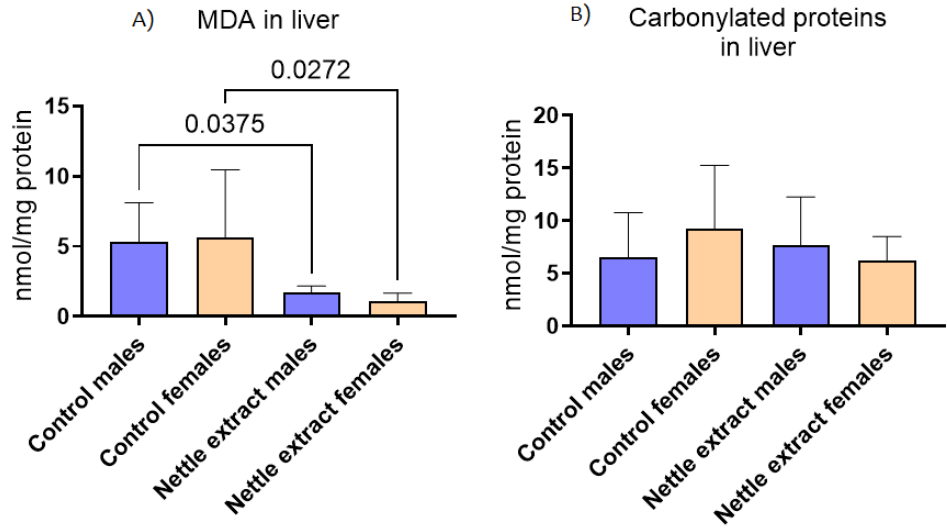
Figure 5. The changes in ( A ) malonaldehyde (MDA) and ( B ) carbonylated proteins in the liver of C57Bl6 mice treated with nettle extract. The numbers above bars are p values meaning statistically significant ( p ≤ 0.05) differences between the treated groups by Kruskal – Wallis ANOVA.